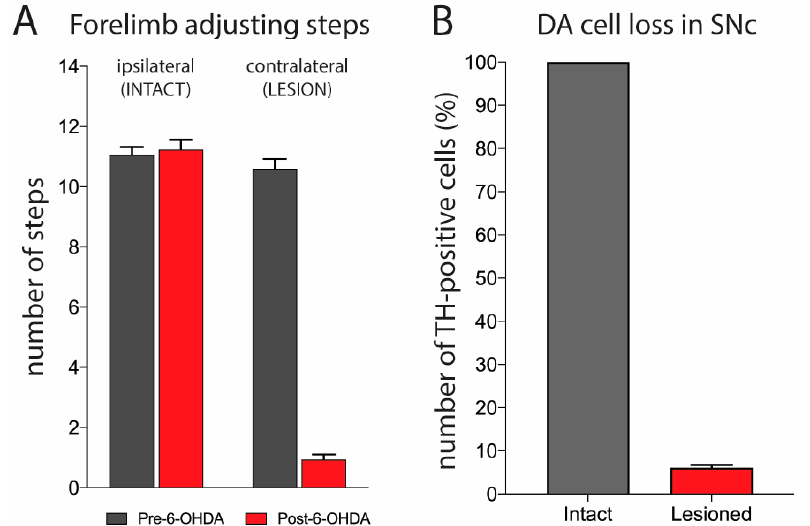
Figure 1. Unilateral DA lesion by 6-OHDA produces a contralateral forelimb stepping deficit. ( A ) Forelimb stepping scores (mean ± SEM) in tests performed pre- and four weeks post-surgery. These tests revealed that the 6-OHDA lesion produced a stepping deficit in the forelimb contralateral to the lesion, while stepping with the ipsilateral (intact) forelimb was not affected. The stepping scores given are from the included animals that showed three or fewer adjusting steps with the contralateral forelimb (n = 33). ( B ) Number of TH-positive cells in the SNc ipsilateral to the lesion, expressed as percentage of the TH-positive cells on the intact side. The included animals displayed a loss of 87.9–98.6% of TH-positive (DA) neurons on the side of the lesion (mean ± SEM, 93.95 ± 0.72% of intact side).